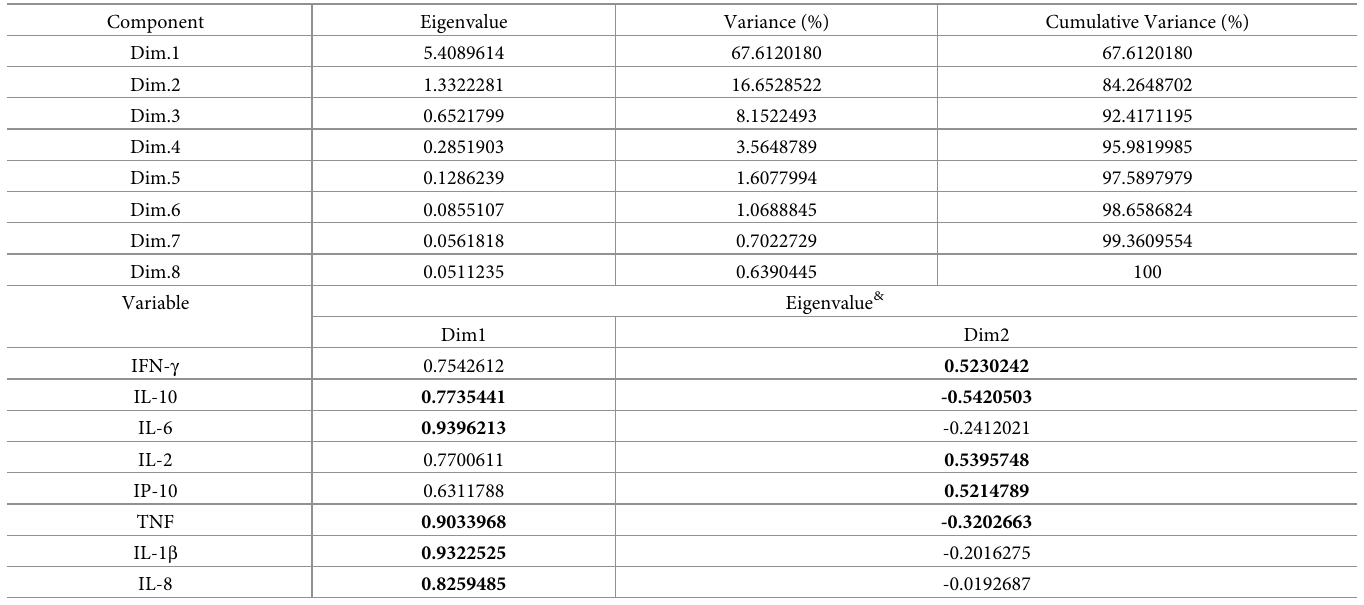
Table 2. Principal-component analysis of inflammatory biomarkers in plasma from patients with COVID-19 and unexposed